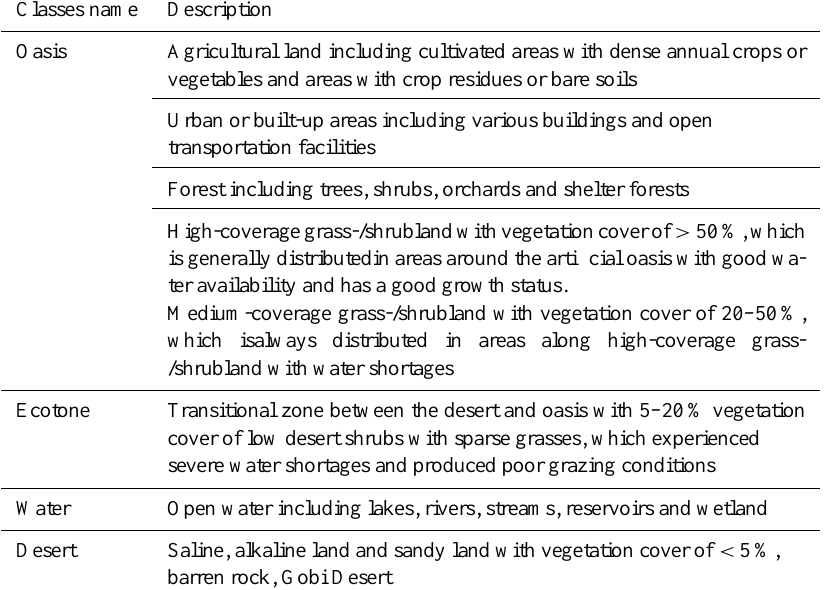
Table 1. Description of major land cover types defined in this study. Classes